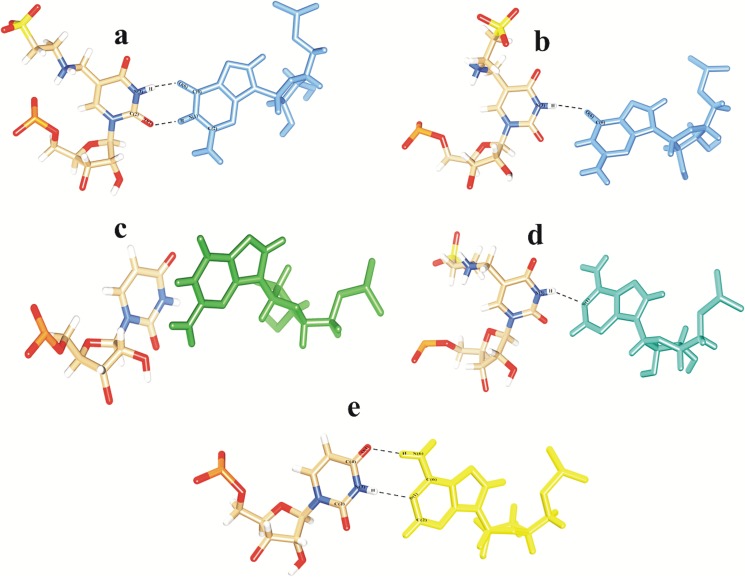
Hydrogen bonding interactions of a) τm5U34:G3 in tRNALeu showing recognition by double bond, b) τm5U34:G3 in tRNALeu showing single bond recognition, c) U34:G3 in tRNALeu showing no bonding interactions, d) τm5U34:A3 in tRNALeu showing single bond, e) U34:A3 in tRNALeu showing double bond, f) U34:A3 in tRNALeu showing bonding interactions.